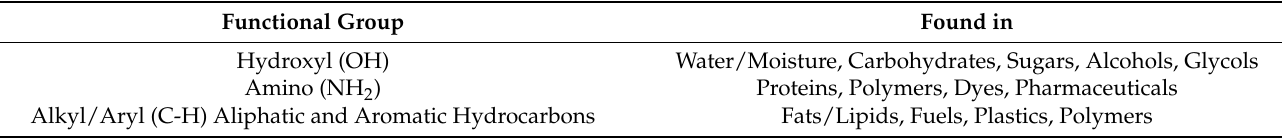
Table 3. Diagnostic functional group of NIR absorptions